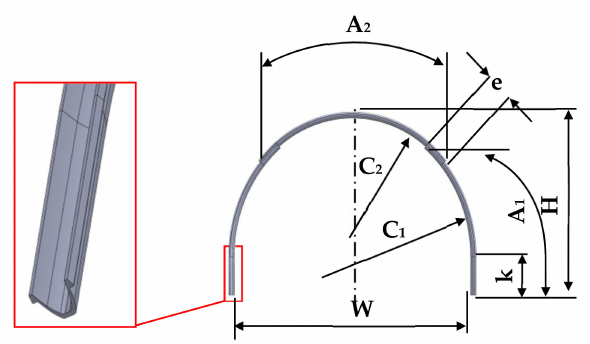
Figure 4. An overview drawing of the basic dimensions of the arch support type 10. Using the possibilities and functionality of the software used, a solid model of the excavation was developed to create a numerical grid, and the effects of the actions taken are presented in Figure 5.